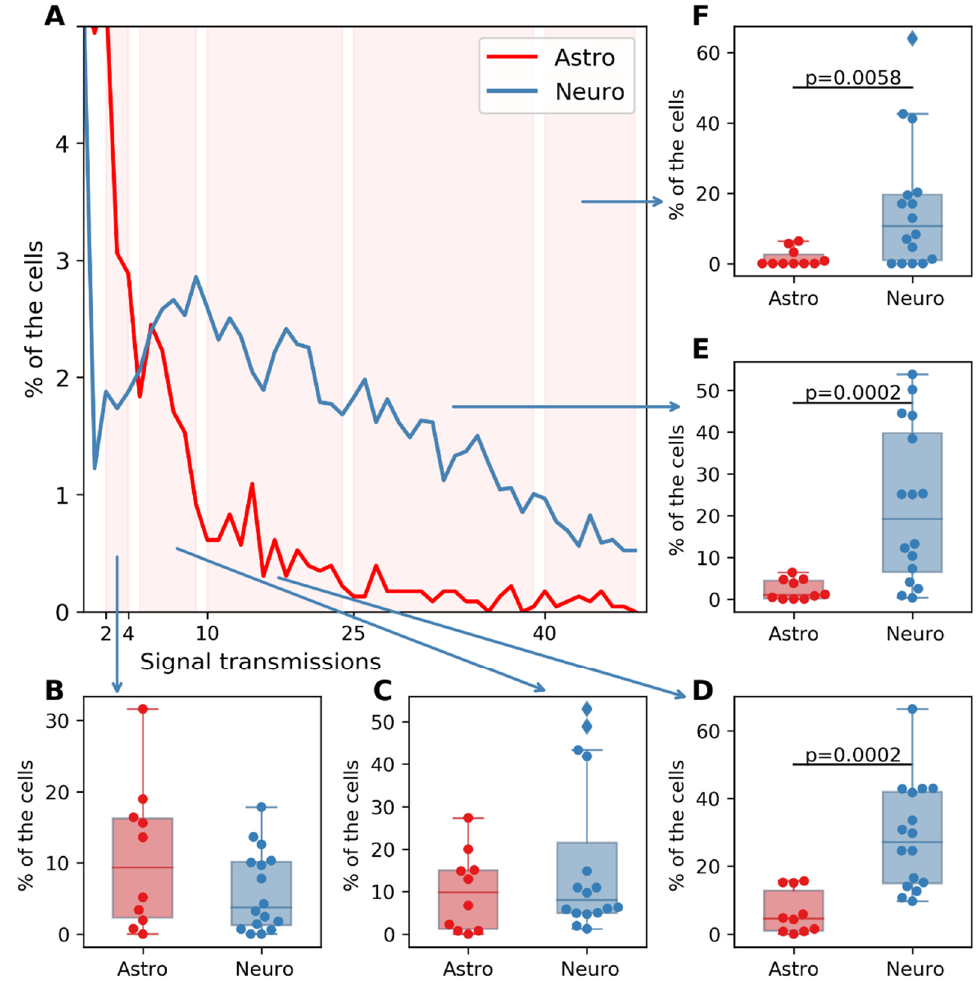
Figure 6. ( A ) Group histograms of cultures of intact astrocytes (red) and intact neurons (blue). ( B ) Percentage of cells with 2 to 4 transmissions. ( C ) Percentage of cells with 5 to 10 transmissions. ( D ) Percentage of cells with 11 to 24 transmissions. ( E ) Percentage of cells with 25 to 40 transmissions. ( F ) Percentage of cells with more than 40 transmissions. Significant differences between groups were assessed using Mann–Whitney–Wilcoxon tests.